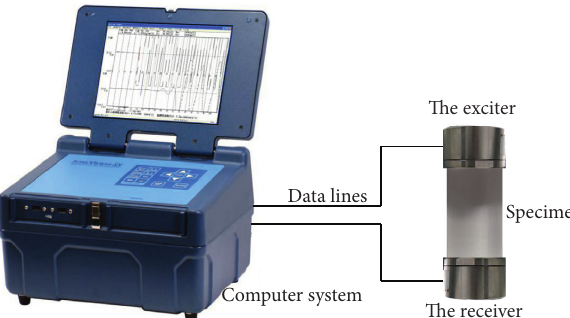
Figure 3: An acoustic velocimeter (SonicViewer-SX) used in measuring the speed of P -wave and S